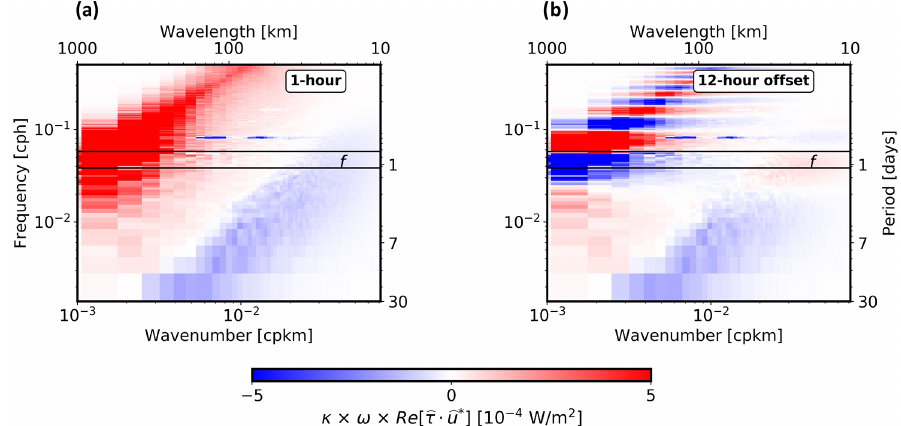
Figure 10. (a) Co-spectrum of wind stresses and surface ocean currents in the Kuroshio Extension region from COAS simulation. (b) Same as (a) except by off-setting wind stresses and surface currents by 12h. Using different off-settings (3 and 6h) produce the same results at